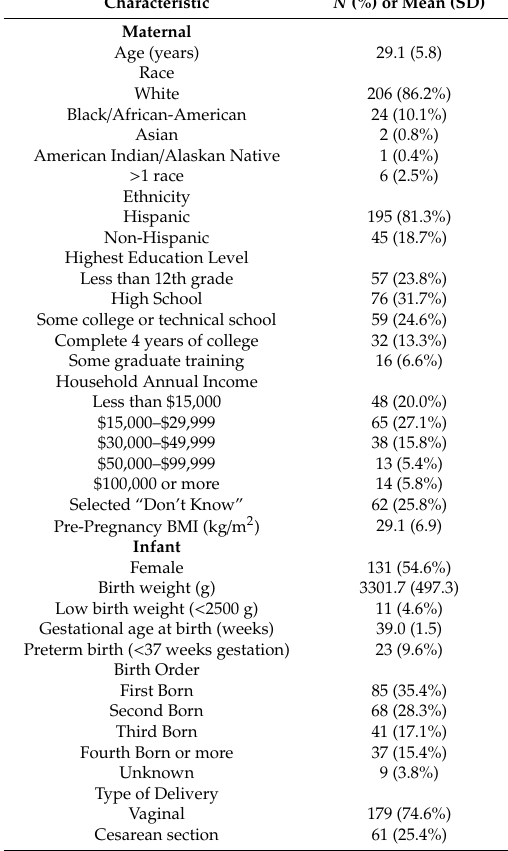
Table 1. Descriptive statistics of 240 mother–infant